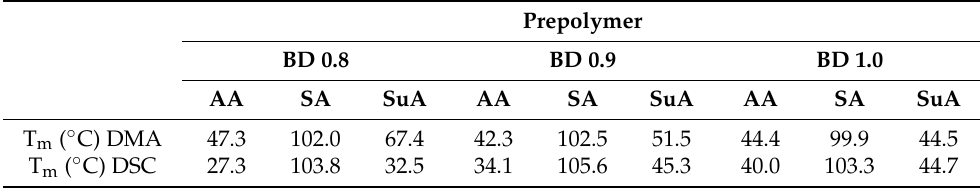
Table 3. Melt temperatures (T m ) of poly(ester-amide) prepolymers after 48 h reaction determined by DMA and DSC.